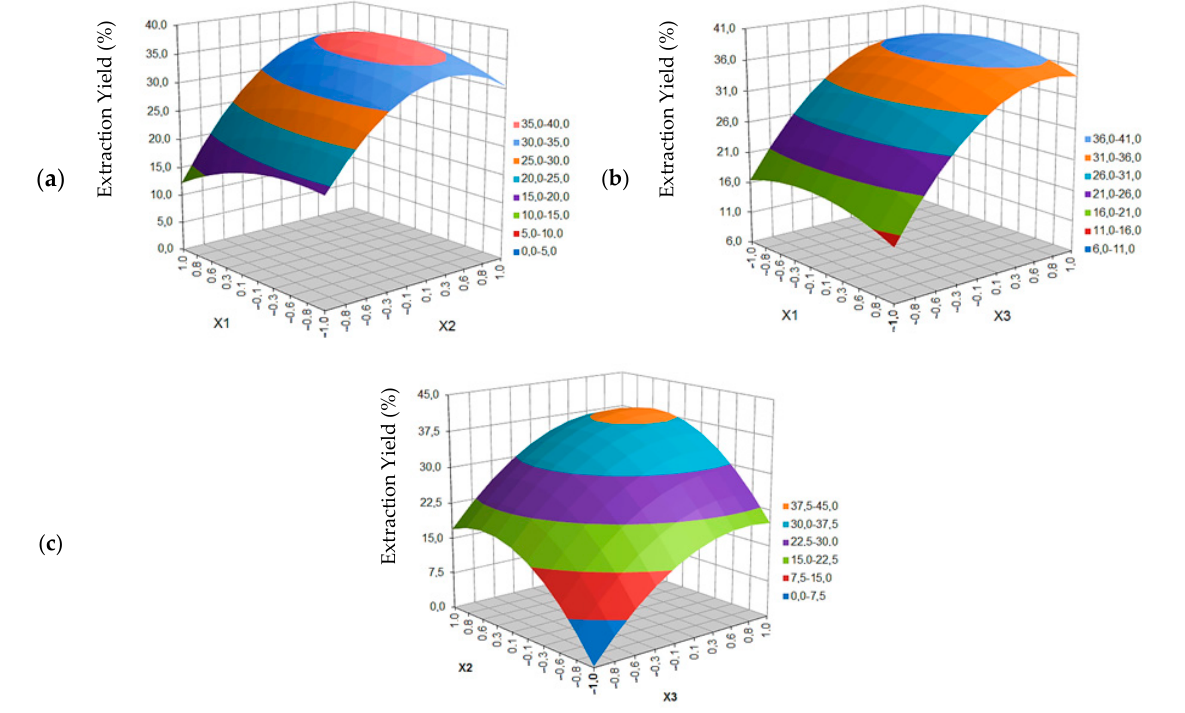
Figure 5. Response surface plot for black cumin seeds extraction yield as a function of: ( a ) temperature (X 1 ) and extraction pressure ( X 2 ), ( b ) temperature ( X 1 ) and extraction time ( X 3 ), ( c ) pressure ( X 2 ) and extraction time ( X 3 ).